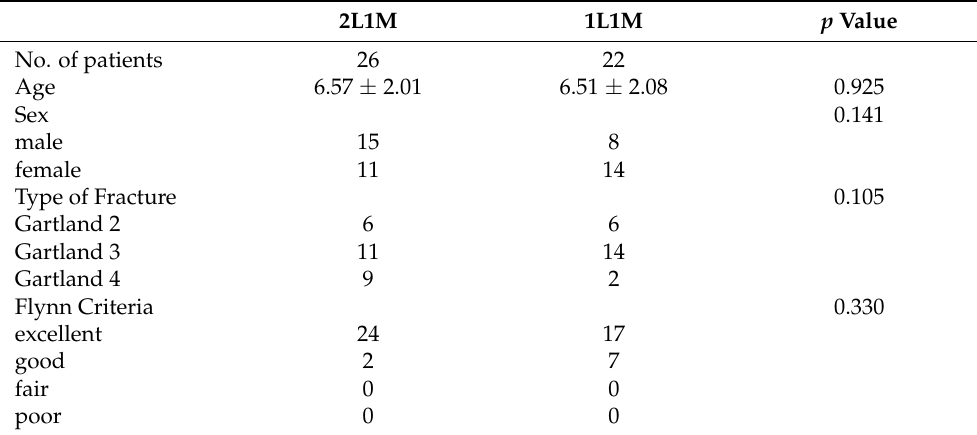
Table 1. Comparison of clinical results and descriptive features between two groups.